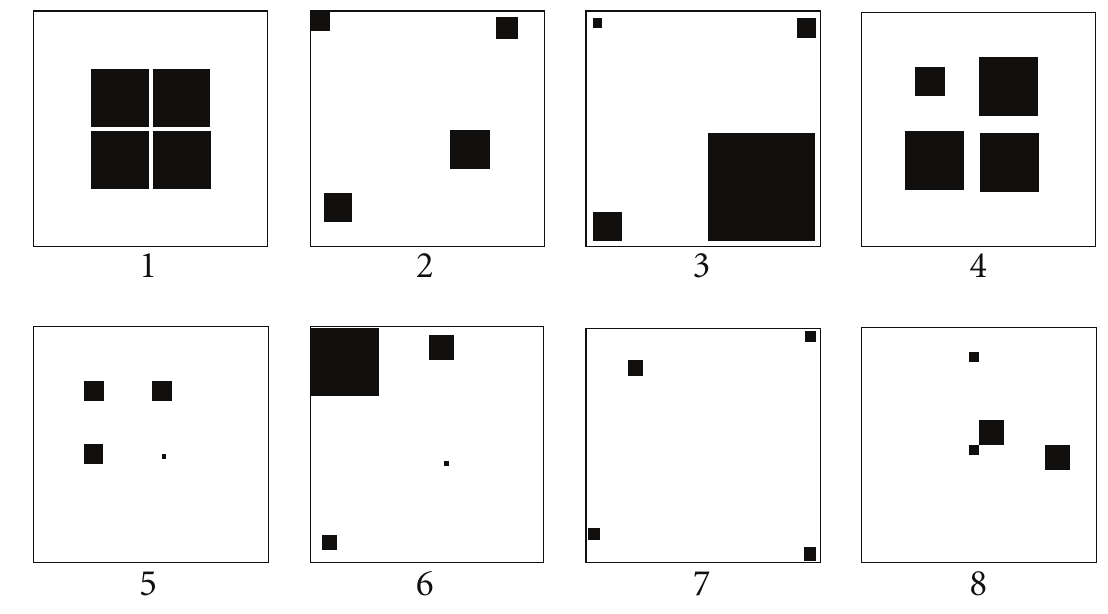
Figure 1: The eight screen models associated with the experimental conditions. Table 1: The eight experimental conditions and the associated factors levels and